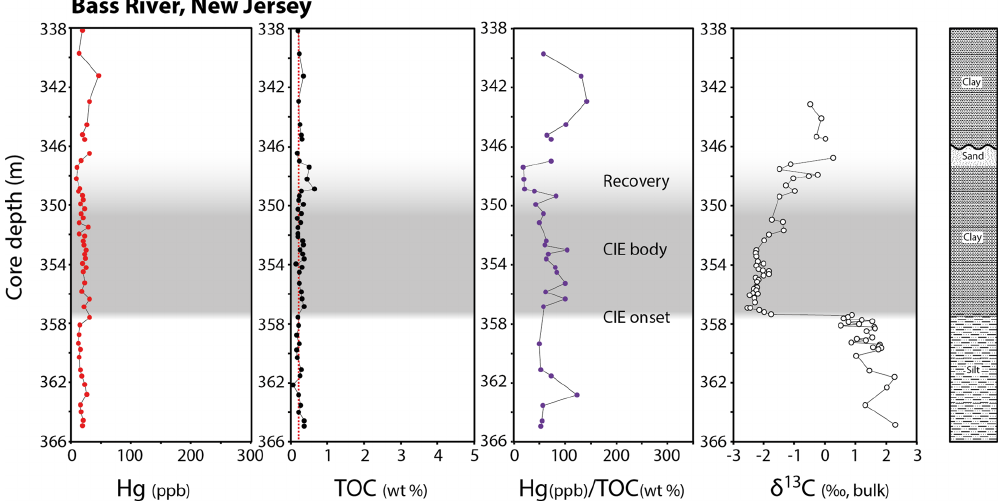
Figure 8. Mercury, TOC, Hg / TOC, and δ 13 C bulk data from the Ocean Drilling Project (ODP) leg 174 Bass River locality (Cramer et al., 1999). The colouring scheme is the same as in Fig. 3, with the exception of δ 13 C bulk , which is shown as white points. The δ 13 C data and stratigraphic log are from John et al. (2008). An unconformity is found at 347.05mb.s. in the stratigraphy (Cramer et al., 1999). The grey shaded area shows the approximate onset, body, and recovery phases of the CIE. The red dashed line in the TOC graph denotes the recommended threshold for TOC concentrations to report Hg / TOC values (Grasby et al., 2016). Samples with TOC values below this threshold were omitted from the Hg / TOC